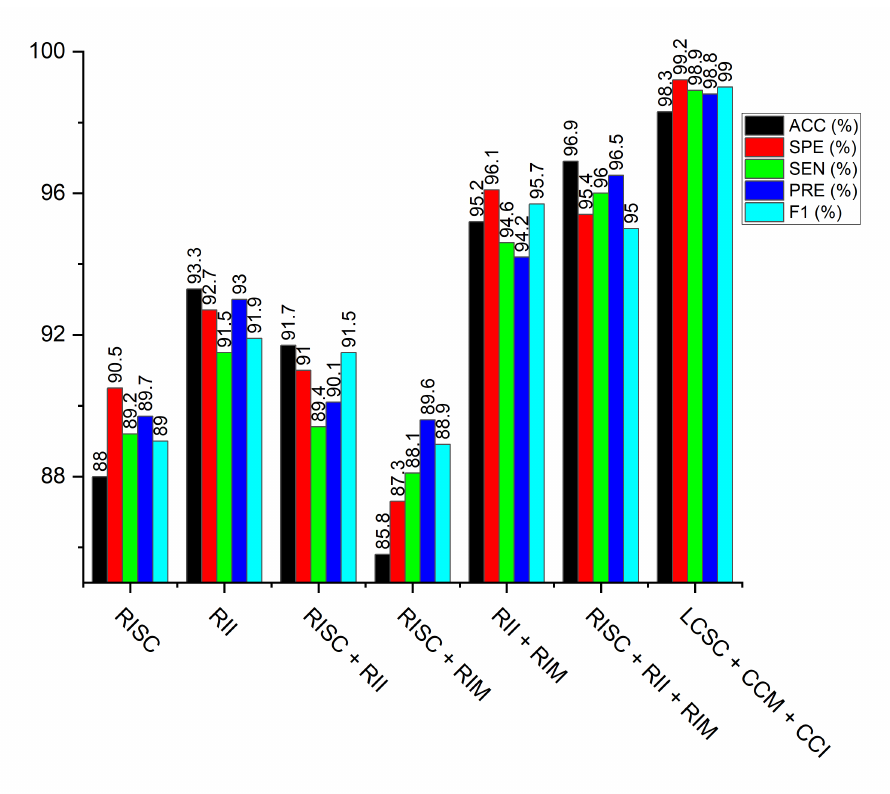
Figure 17. Performance evaluations using the raw chest X-ray